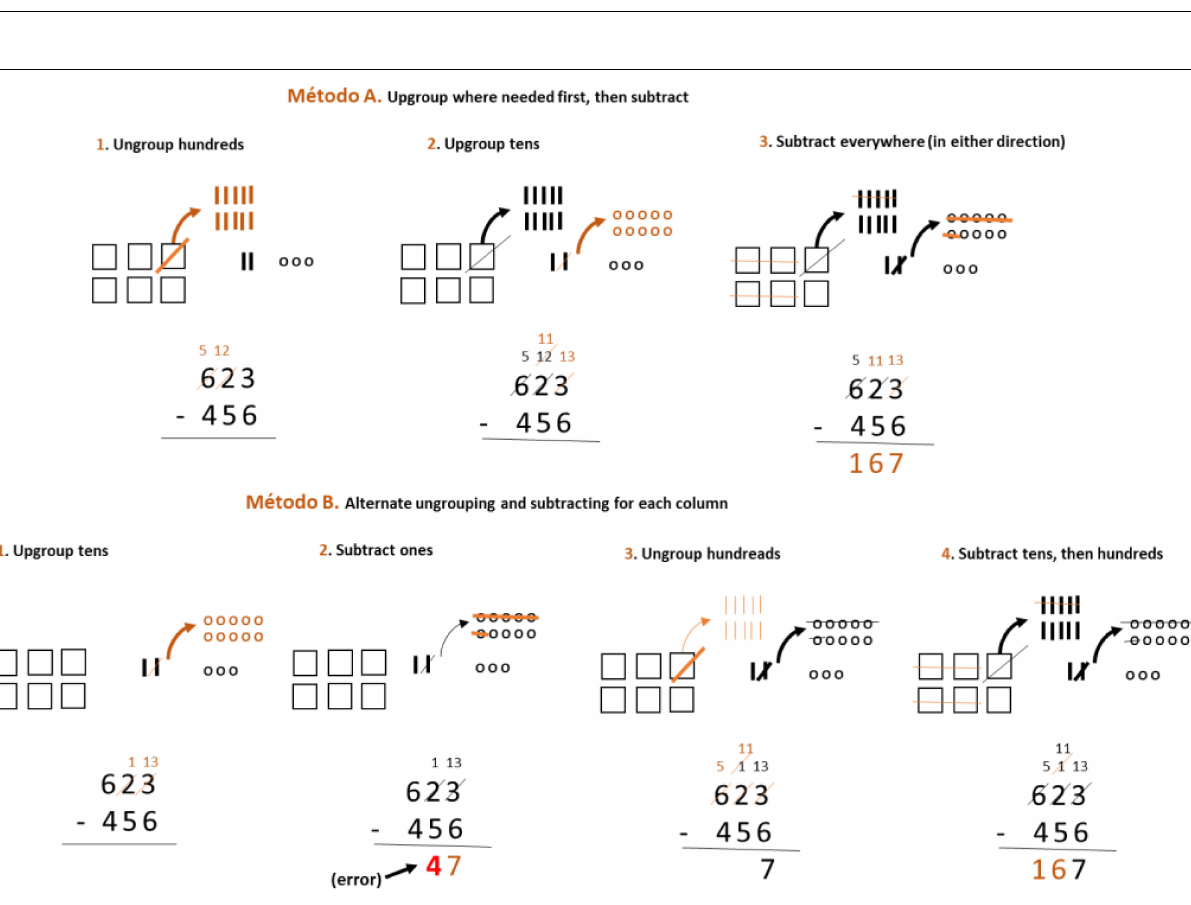
Frontiers in Psychology |